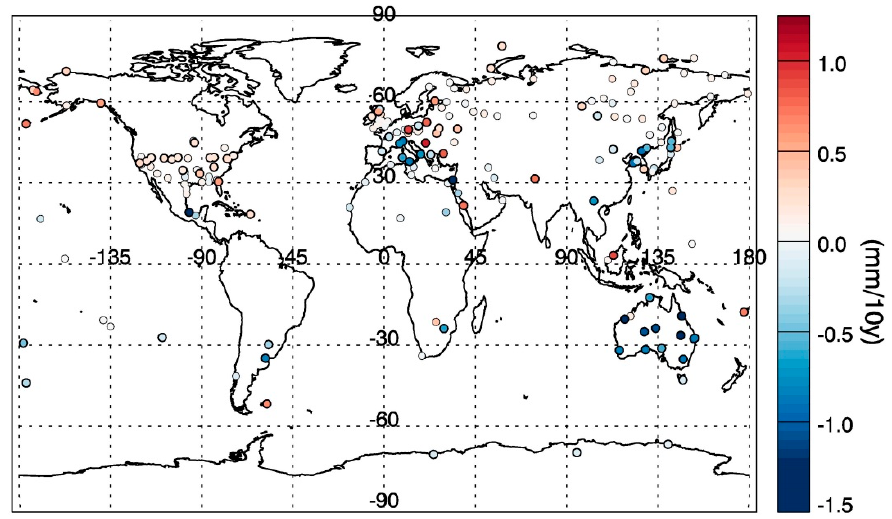
Figure 8. Long-term trends in PW from radiosonde observations for the period of 1957–2016 (stations with bold black circles are stations with significant trends).